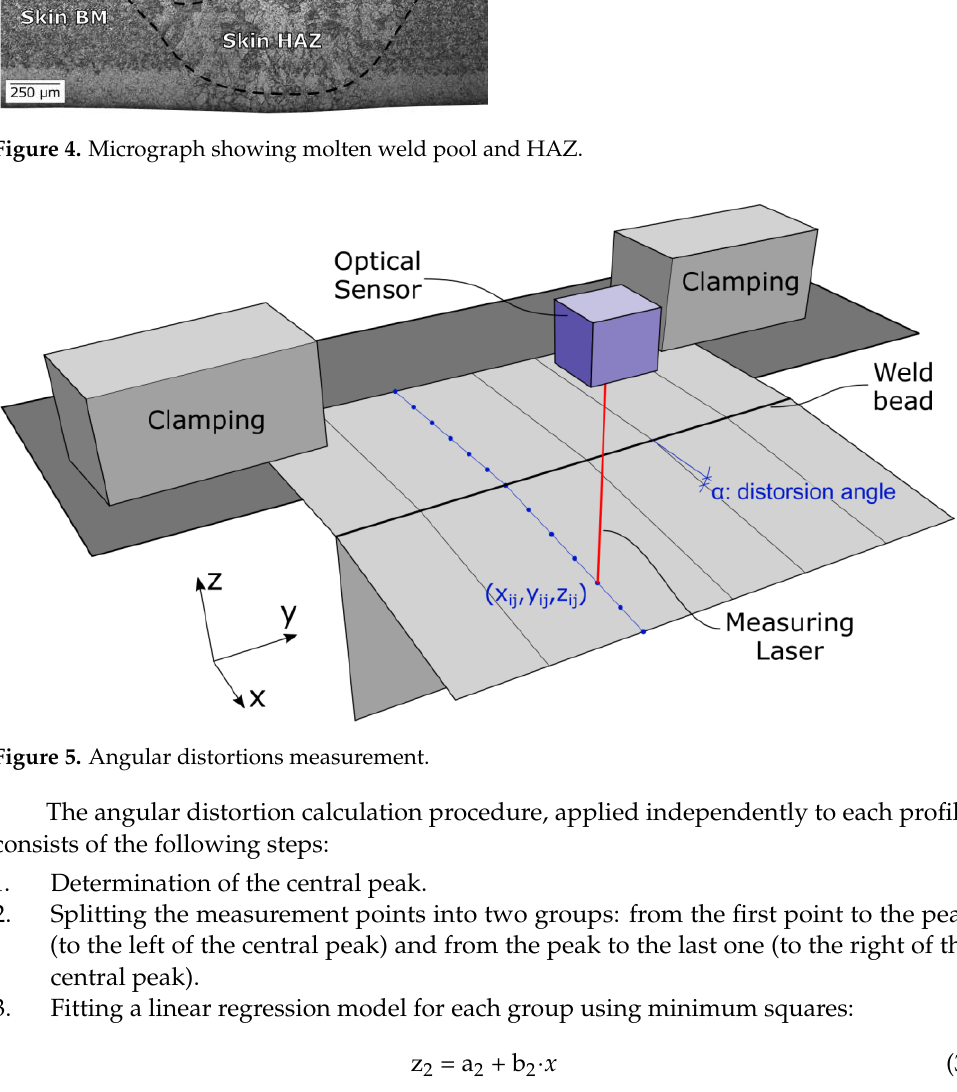
Figure 5. Angular distortions measurement.